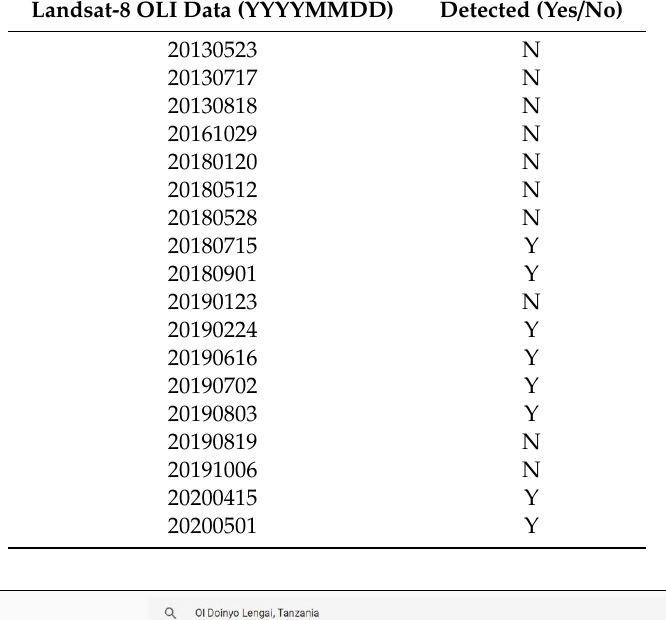
Table 3. L8-OLI data of April 2013 − May 2020, with evidences of thermal anomalies at Oldoynio Lengai (Tanzania; Africa) revealed by the manual inspection of satellite imagery.